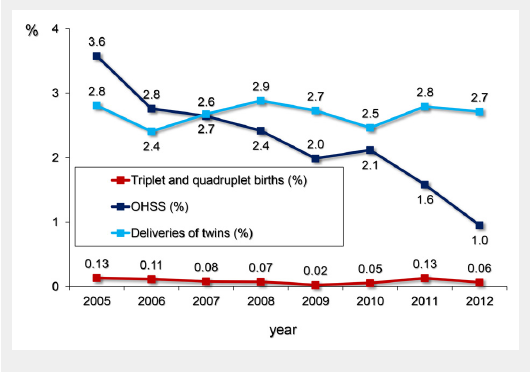
The yearly proportion (%) of twin, triplet and quadruplet deliveries per treatment cycle with ART (including both fresh and thawing cycles) and the proportion of OHSS per freshly stimulated treatment cycles (in %) was calculated from the pooled FIVNAT-CH data collected between 2005 and 2012. While the number of multiple births has remained constant, the incidence of OHSS dropped from 3.6% 1.0%.